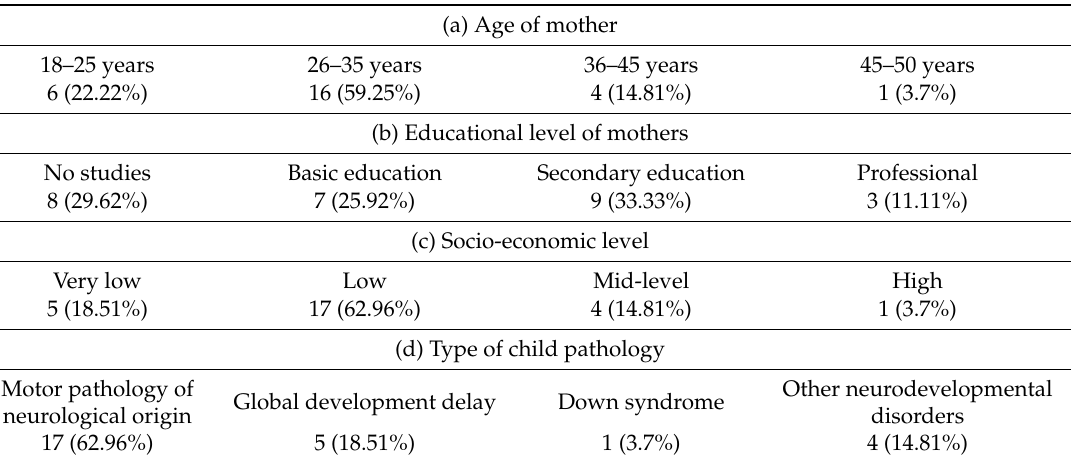
Table 2. Data from the study sample ( n = 27).